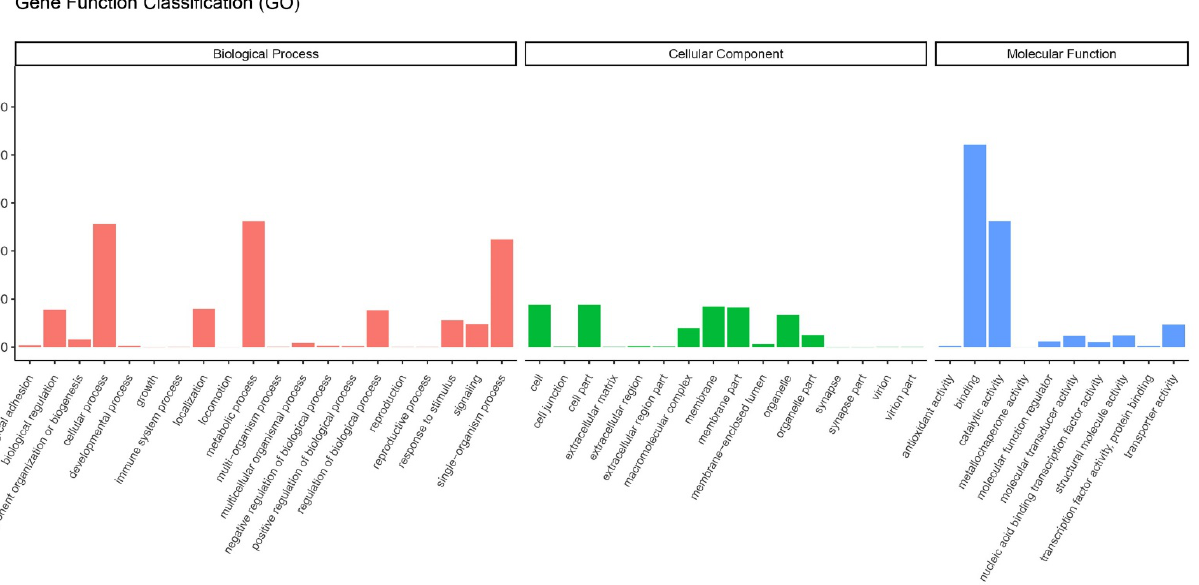
Figure 6. Gene ontology (GO) enrichment analysis of DEGs. GO items were divided into 3 groups: biological processes, cellular components, and molecular functions.